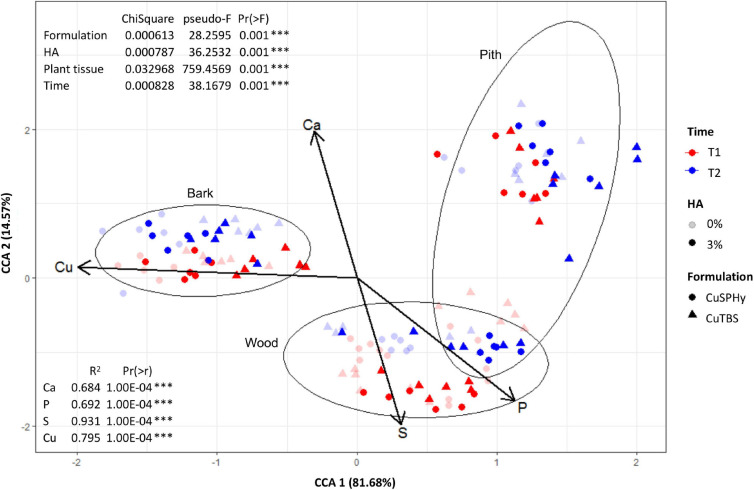
Based on the multi-elementary quantification data (ICP-OES), the constrained correspondence analysis (CCA) was performed (vegan:cca function) to highlight the distribution of each element in the sampled tissues (bark, wood, and pith), on rootstock cuttings (six technical replicates) after their treatment (T1), and on Pmi::gfp7-inoculated plant samples (six technical replicates) harvested 15 weeks post-inoculation (T2). The applied copper(II) compounds (CuSPHy and CuTBS) are spotted as different geometric shapes, with different intensities according to the HA percentage (0 and 6%) and variable color according to the sampling time (T1 and T2). Differences between tissues (bark, wood, and pith) are shown as ellipses at 95% confidence. Vectors of elements were superimposed on main CCA ordination after applying vegan:envfit function. The percentages of variation of eigenvalues are: CCA1 = 81.68% and CCA2 = 14.57%. The significance of each factor was assessed with permutation test on CCA (Supplementary Table 5).